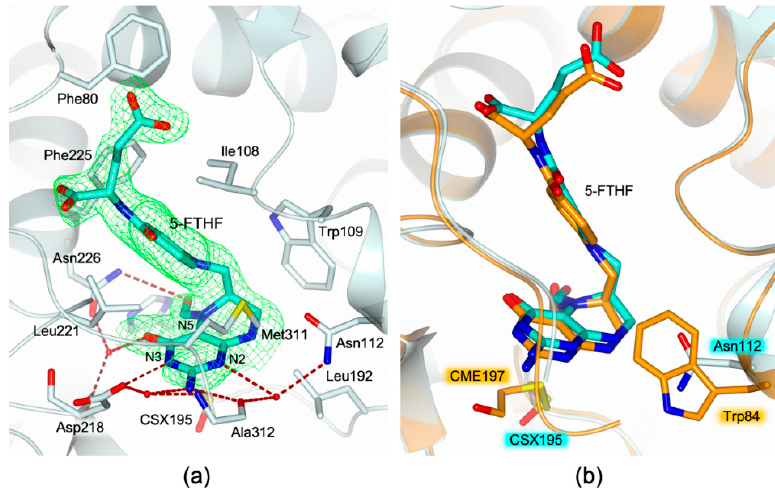
Figure 3. ( a ) Active site view of the B subunit of HT-hTS R175C (light cyan cartoon and carbon atoms). The catalytic Cys195 is modified as S-oxy-cysteine (CSX195, in sticks). The cofactor analogue 5-formyl-6-tetrahydrofolate (5-FTHF, in sticks, cyan carbons) is entrapped within the enzyme active site by a tight network of H-bonds (tan dashed lines) and van der Waals interactions. The ligand is surrounded by the omit map contoured at the 3 σ level. ( b ) Active site view of the superimposition between the structures of HT-hTS R175C (light cyan cartoon and carbon atoms) and the bacterial Enterococcus faecalis TS ( Ef TS, orange cartoon and carbon atoms; PDB id 3UWL [18]). In both structures, the active site of the enzyme is populated by the cofactor analogue 5-FTHF (in sticks, carbons are colored cyan and orange in HT-hTS R175C and Ef TS, respectively). The binding mode of the ligand is conserved in both complexes. The catalytic cysteine is modified as S-oxy-cysteine (CSX195, in sticks) in the structure of HT-hTS R175C, and as S,S-(2-hydroxyethyl)thiocysteine (CME197, in sticks) in Ef TS.